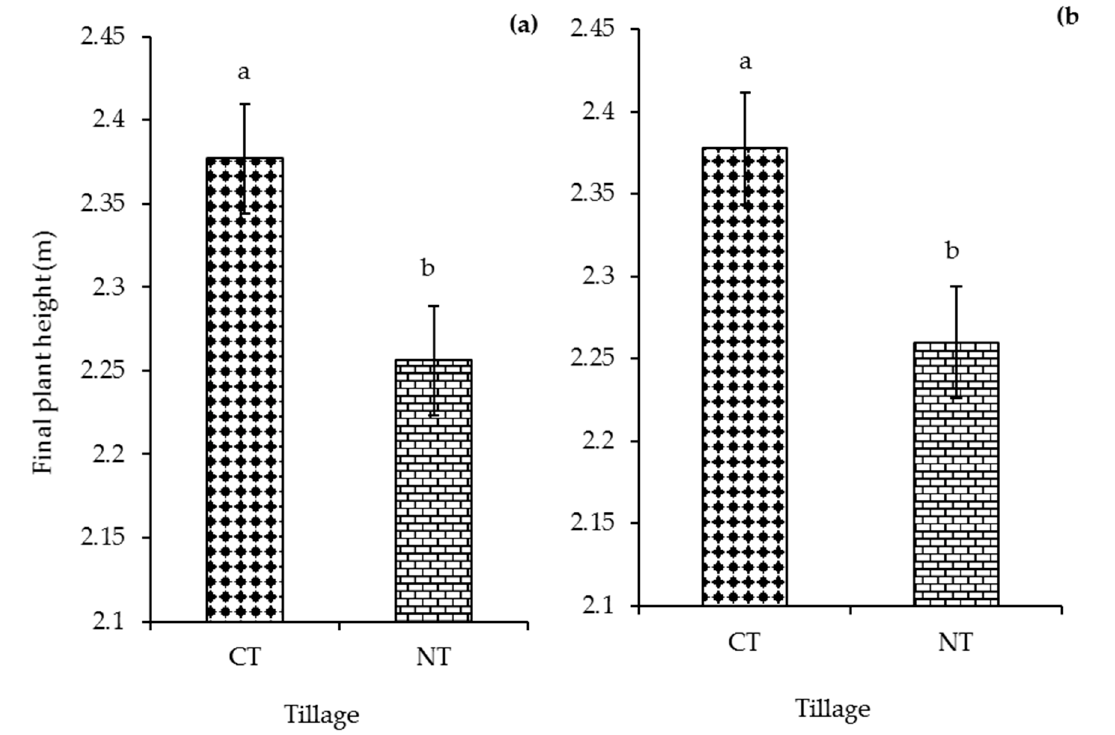
Figure 6. E ff ect of tillage on the final plant height of a maize crop in the ( a ) 2015 / 2016 and ( b ) 2017 / 2018 Figure 6. Effect of tillage on the final plant height of a maize crop in the ( a ) 2015/2016 and ( b ) 2017/2018 summer seasons in a semiarid climate in South Africa. Di ff erent lowercase letters indicate significant summer seasons in a semiarid climate in South Africa. Different lowercase letters indicate significant di ff erences at p ≤ differences at p ≤ 0.05.